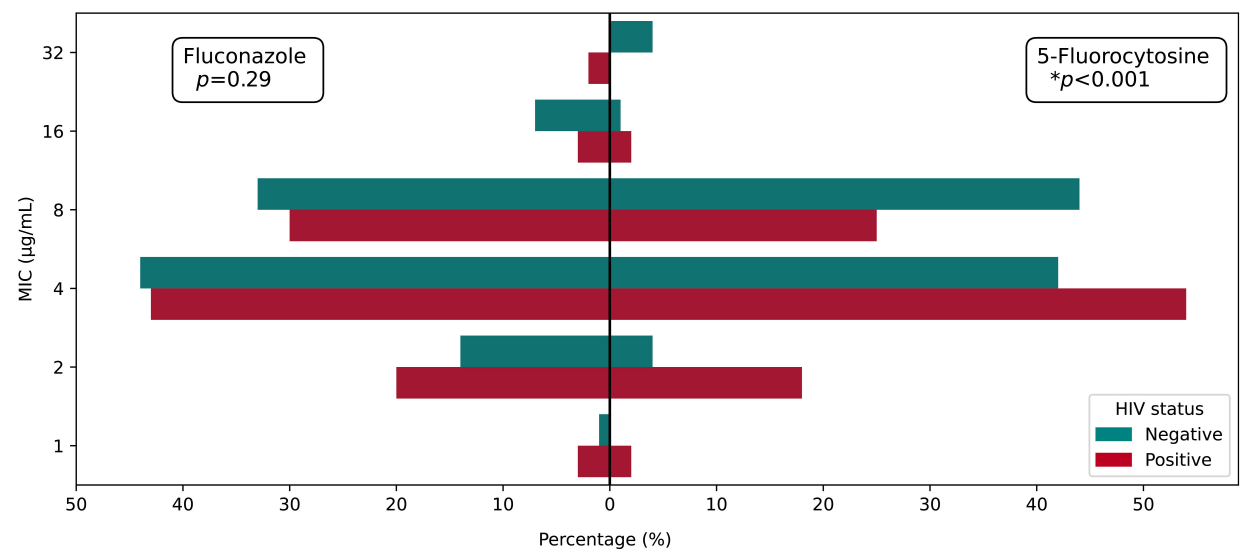
FIGURE 1 | MIC distribution of fluconazole and 5-fluorocytosine among HIV-positive and HIV-negative groups.